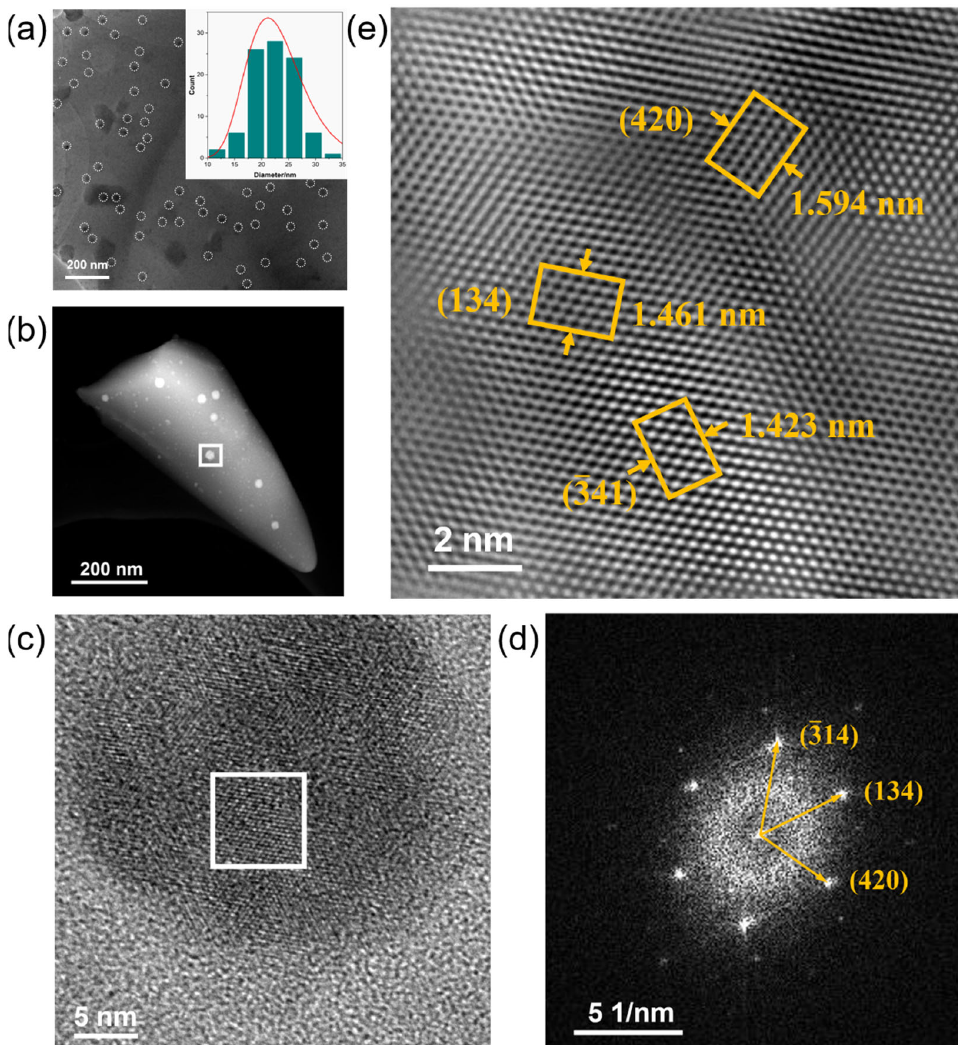
Figure 4. ( a ) TEM image of YABS glass, single nanocrystals are marked with white ellipses, the inset shows the particle size statistics of nanocrystals; ( b ) Transmission electron dark-field imaging of YABS glass; ( c ) Local enlargement of the white frame area in ( b ); ( d ) Fast Fourier Transform (FFT) of the white frame area in ( c ); ( e ) Lattice fringe image filtered by inverse Fourier transform (IFFT) of crystal diffraction pattern.